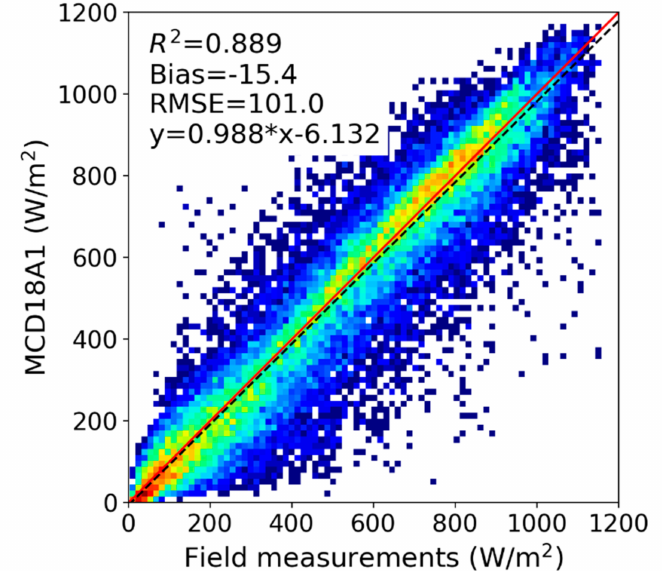
Figure 3. Validation results of all the MCD18A1 instantaneous DSR data which are aggregated to 50-by-50 km